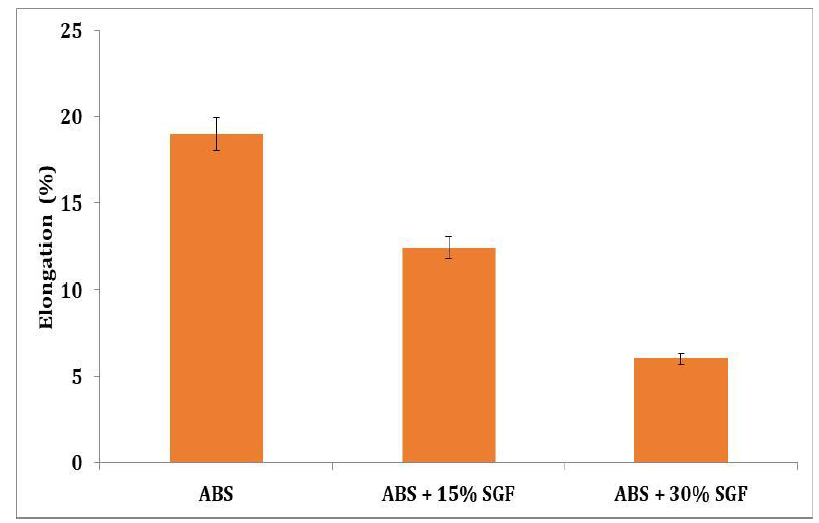
Figure 11. Variation of percentage elongation with short glass fibre content.